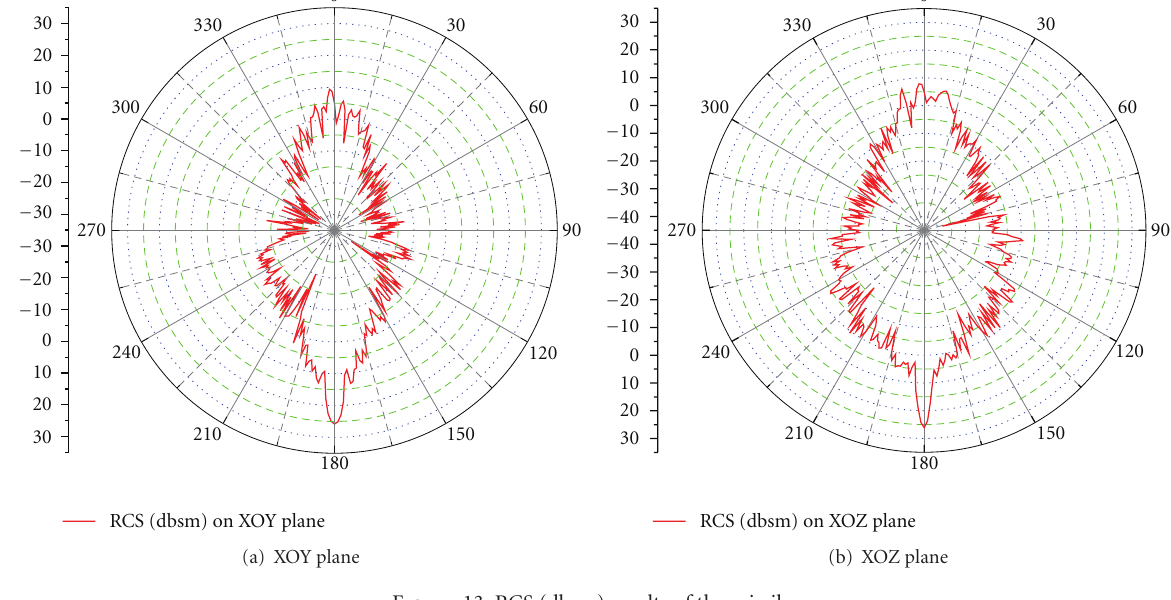
Figure 13: RCS (dbsm) results of the missile.